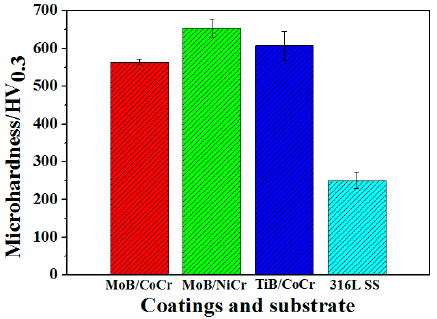
12 of 20 Figure 13. Cross-sectional morphologies and compositions of the TiB/CoCr coating: ( a ) 500×, and ( b ) 10000×. Figure 14. Boride contents of the coatings. 3.4. Microhardness and Bond Strength of As-Sprayed Coatings